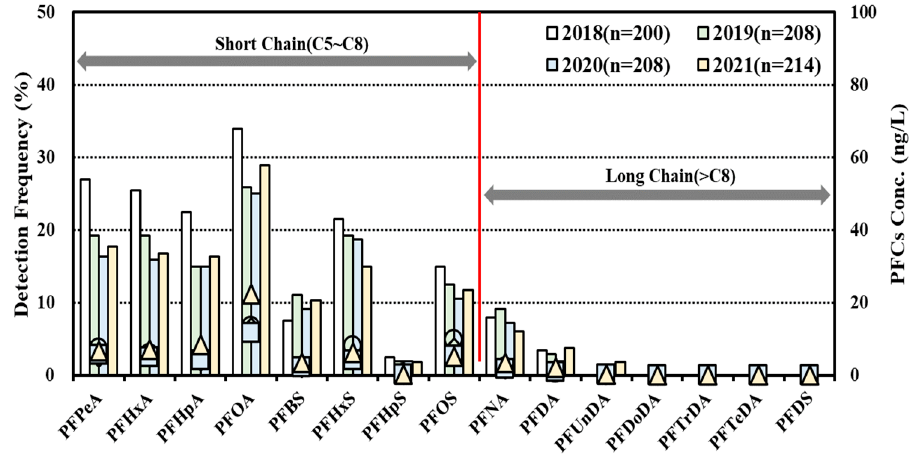
Figure 2. Detection frequencies and average concentration of PFASs.